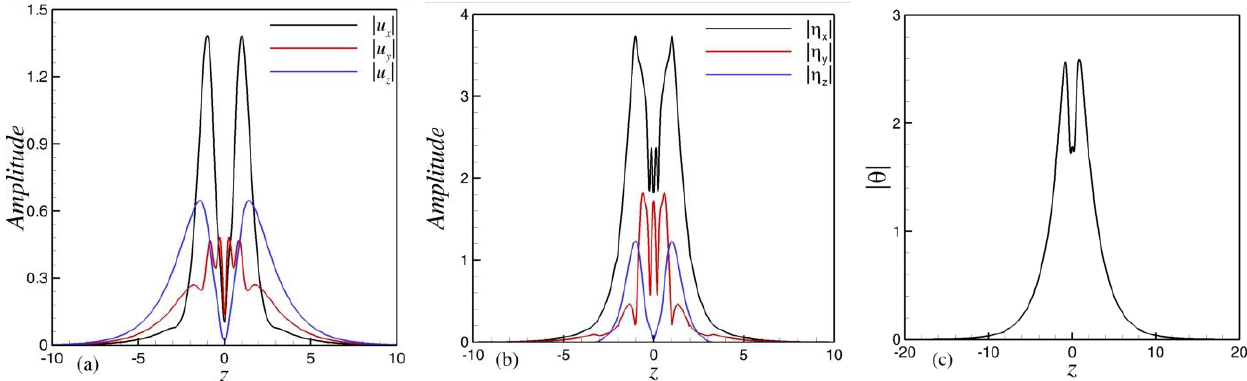
Figure 6. Amplitudes of the initial optimal disturbance for Ri = 2, Re = 1000, α = 0.5, β = 1 yielding the maximal growth at t max = 10; ( a ) three components of velocity magnitude; ( b ) three vorticity components; ( c ) amplitude of the temperature disturbance.